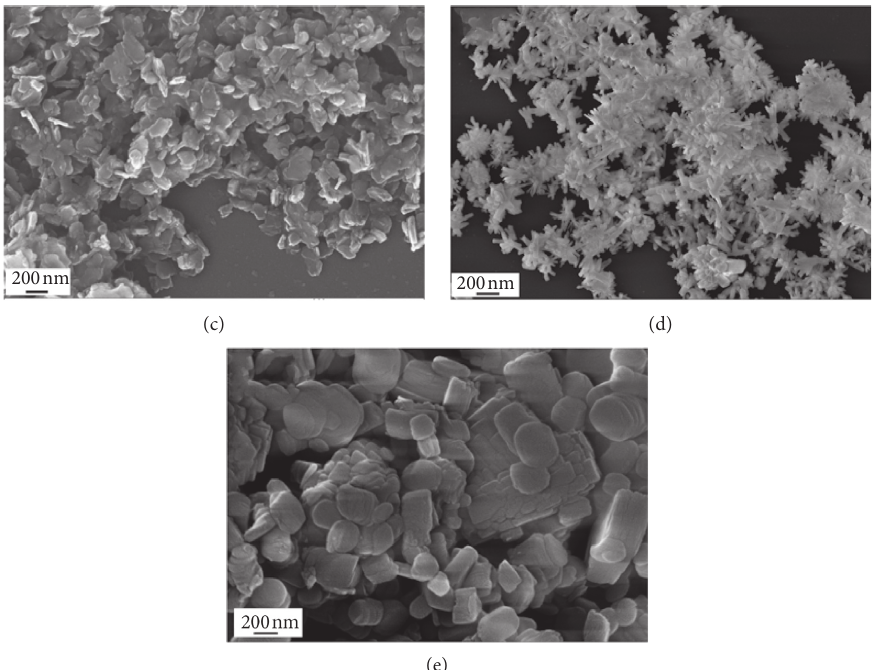
Figure 13: SEM images of (a) LEuH-flocs, (b) LEuH-flocs +fluoride ions, (c) LEuH-spinels obtained after calcination of LEuH-flocs at 500 ° C, (d) LEuH-fluoride adsorbed sample using LEuH-spinels as adsorbent, and (e) self-assembly of LEuH-flocs with NaCl to reproduce the original LEuH-Cl